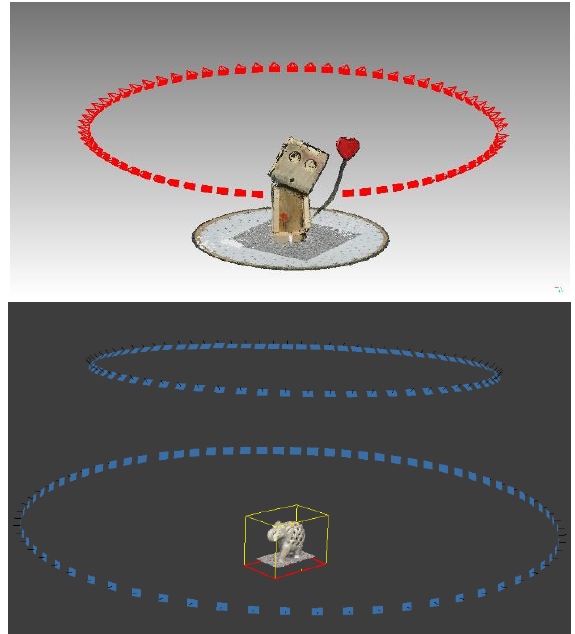
Figure 5: Two examples of circular camera networks achieved with a single camera placed at one (up) and two (below) heights. The images were processed respectively inColmap (up) and Photoscan